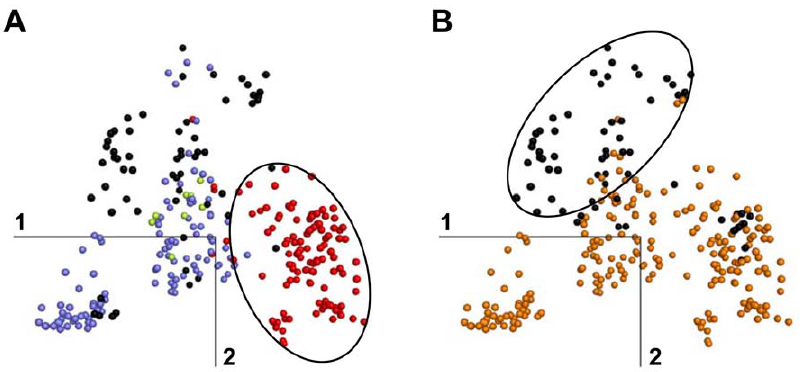
Figure 8. Proline patterns of human GPCRs. In (A), receptors with a proline residue at position 2.58, 2.59 or 2.60 in TM2 are red, slate or light green, respectively. Receptors with no proline in TM2 are black. The ellipse indicates G1 receptors. In (B), receptors with and without a proline residue at position 5.50 in TM5 are orange and black, respectively. The ellipse indicates G3 receptors.